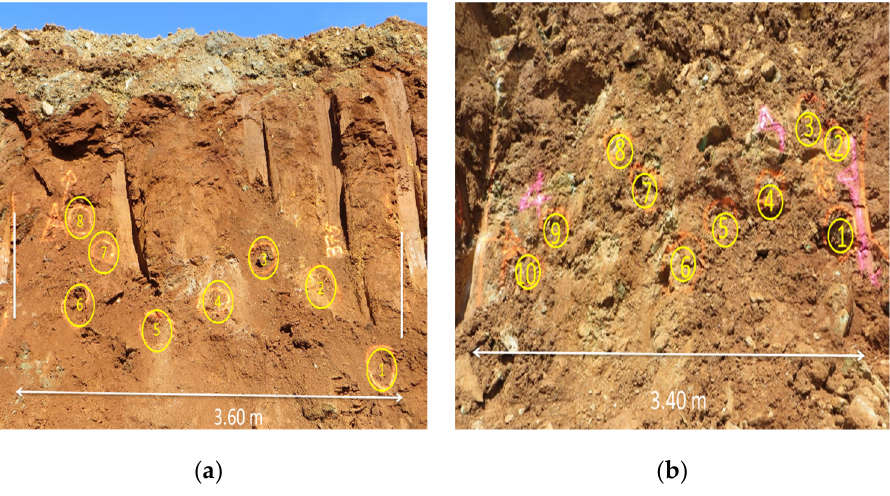
Figure 3. Examples of Ni ore panels sampled during the project: ( a ) Limonite; ( b ) Saprolite. During the second campaign, 18 samples (12 limonites and 6 saprolites) were collected. Concentrations range from 1.31 wt% to 4.47 wt% for Ni and from 8.8 wt% to 52.4 wt% for Fe.